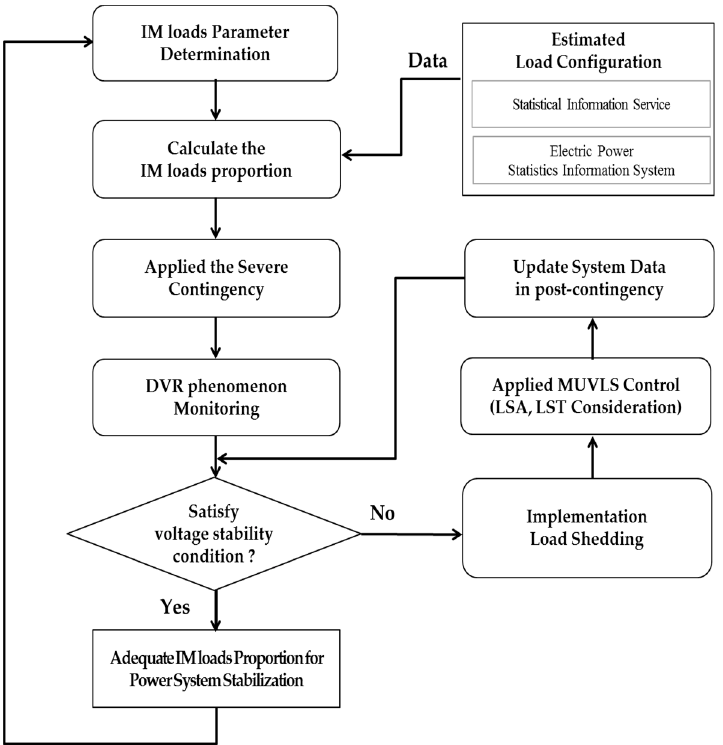
Figure 9. Flowchart of the proposed multi-phase under voltage load shedding (MUVLS) strategy.